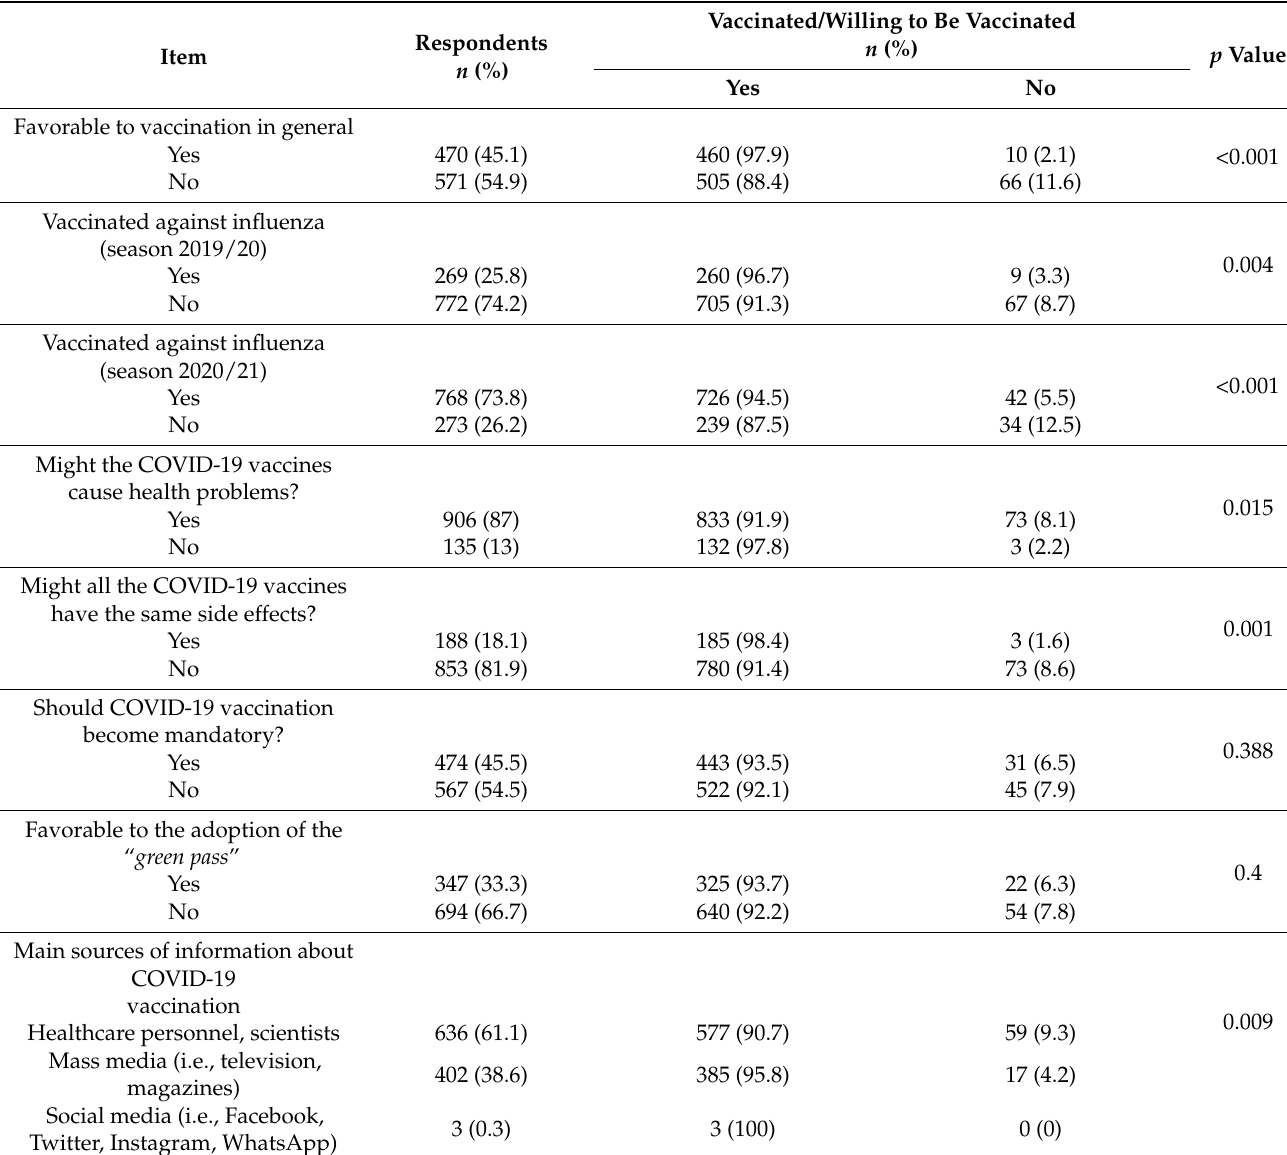
Table 3. Answers regarding vaccinations and COVID-19 vaccination provided by respondents on the whole and grouped by willingness/unwillingness to be